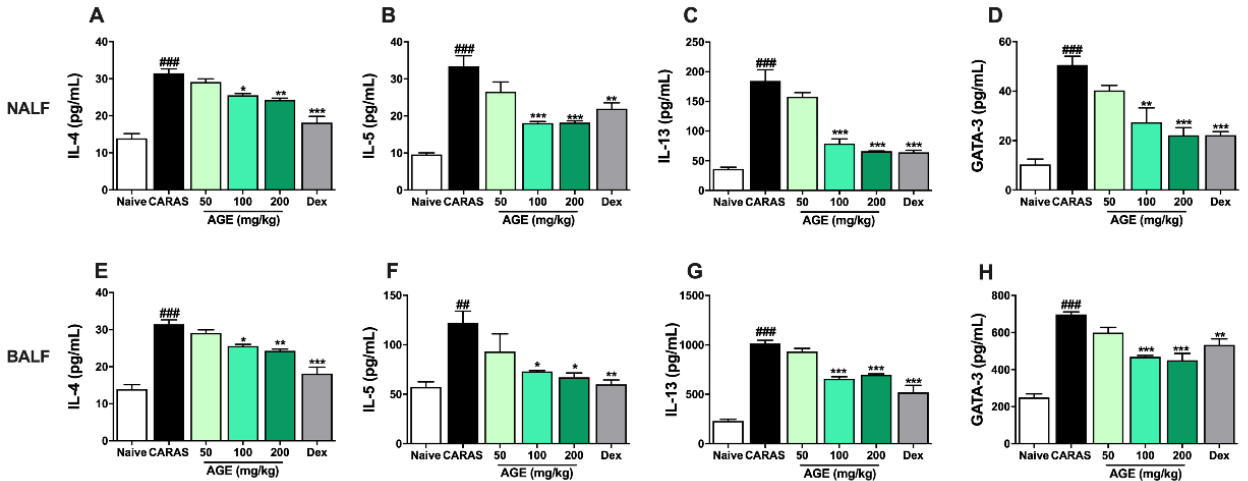
Figure 7. AGE decreased TH2 cytokines and TH2 transcription factor in NALF and BALF of CARAS mice. The levels of ( A ) IL-4, ( B ) IL-5, ( C ) IL-13, and ( D ) GATA-3 in NALF and ( E ) IL-4, ( F ) IL- 5, ( G ) IL-13, and ( H ) GATA-3 in BALF. The levels of TH2 cytokines IL-4, IL-5, IL-13, and TH2 transcription factor GATA-3 in NALF were significantly suppressed by AGE 200 mg/kg or Dex 2.5 mg/kg. The levels of IL-4 and IL-5 in BALF also notably decreased in the AGE 200 and Dex group. All results are shown as the mean ± SD (n = 6 per group). # Compared to naive, * compared to CARAS. ### , *** p < 0.001; ## , ** p < 0.01; * p < 0.05. CARAS = combined allergic rhinitis and asthma syndrome; AGE = Artemisia gmelinii extracts; Dex = dexamethasone; NALF = nasal lavage fluid; BALF = bronchoalveolar lavage fluid; IL =